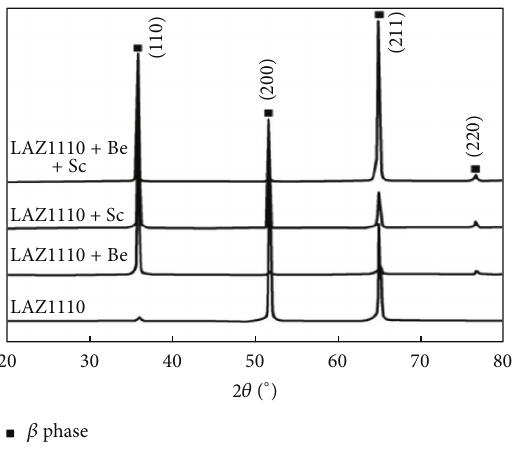
Figure 5: XRD patterns of solution-treated alloy specimens [1].